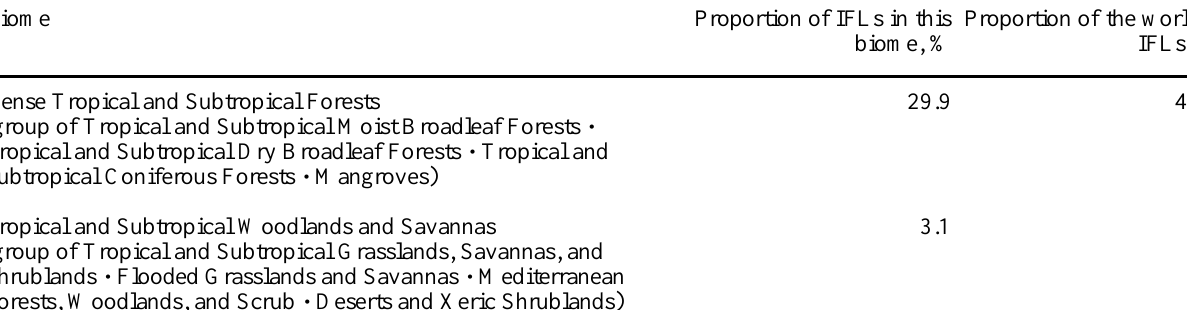
Table 1. Distribution of IFLs within major forest biomes. Biome Proportion of IFLs in this Dense Tropical and Subtropical Forests (group of Tropical and Subtropical Moist Broadleaf Forests